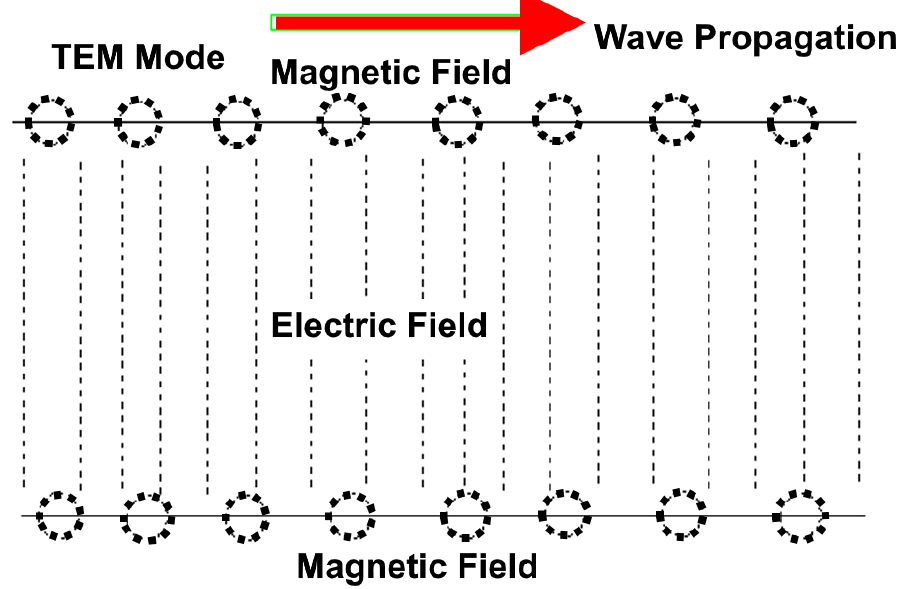
Figure 13. Transverse electromagnetic (TEM) mode propagation of a waveguide.